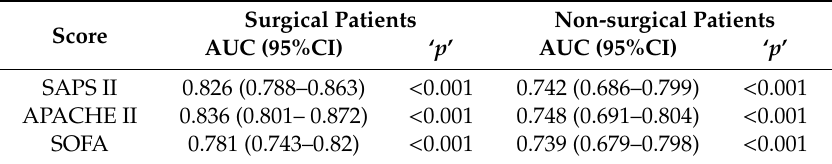
Table 3. Diagnostic accuracy of SAPS II, APACHE II, and SOFA scales in ICU mortality prediction among surgical and nonsurgical patients. Surgical Patients Score